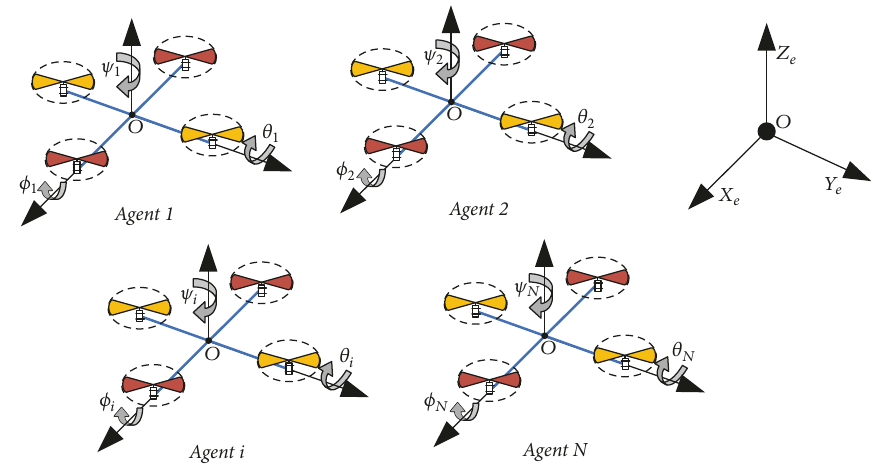
Figure 1: Group of the 𝑁 quadrotor